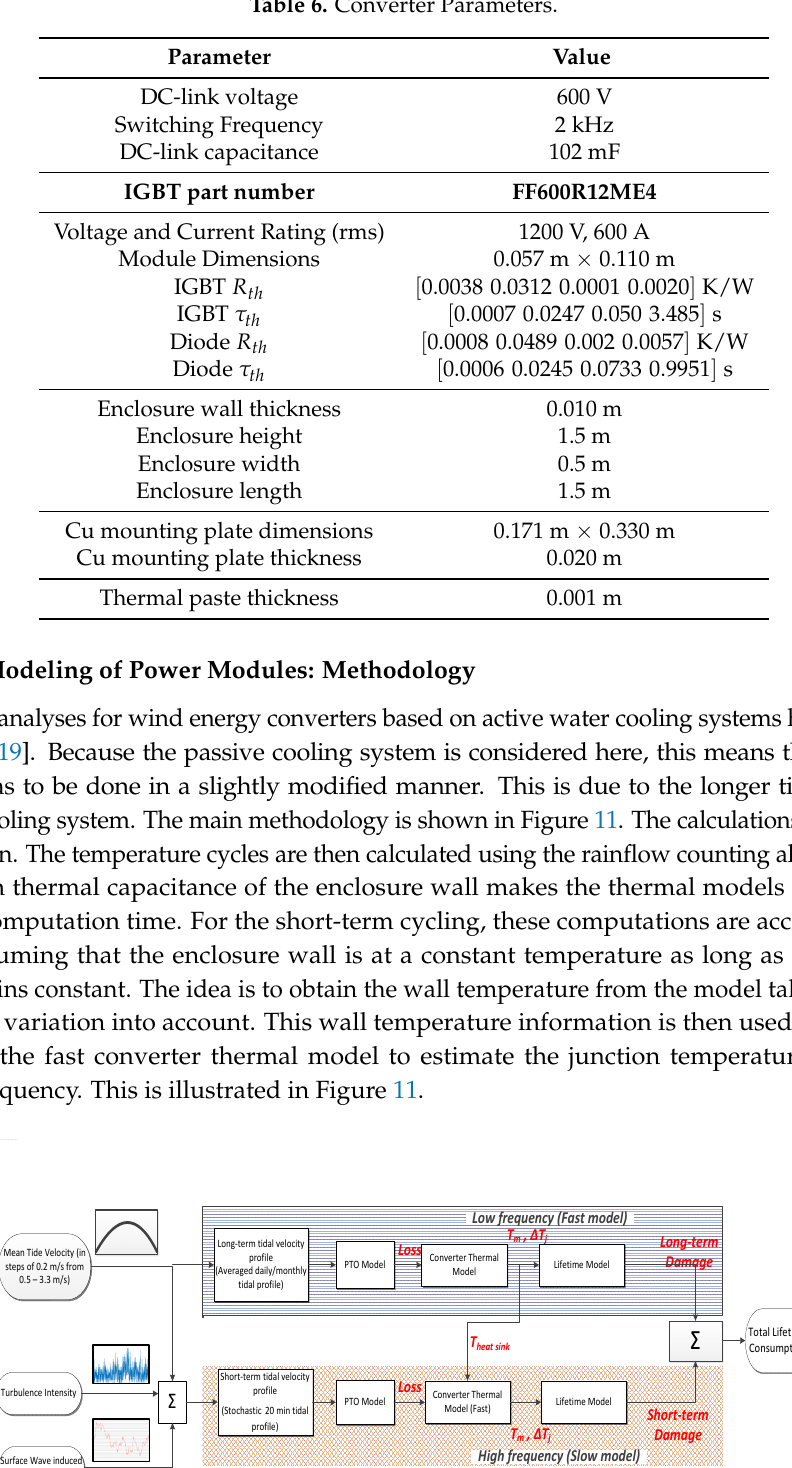
Table 6. Converter Parameters.